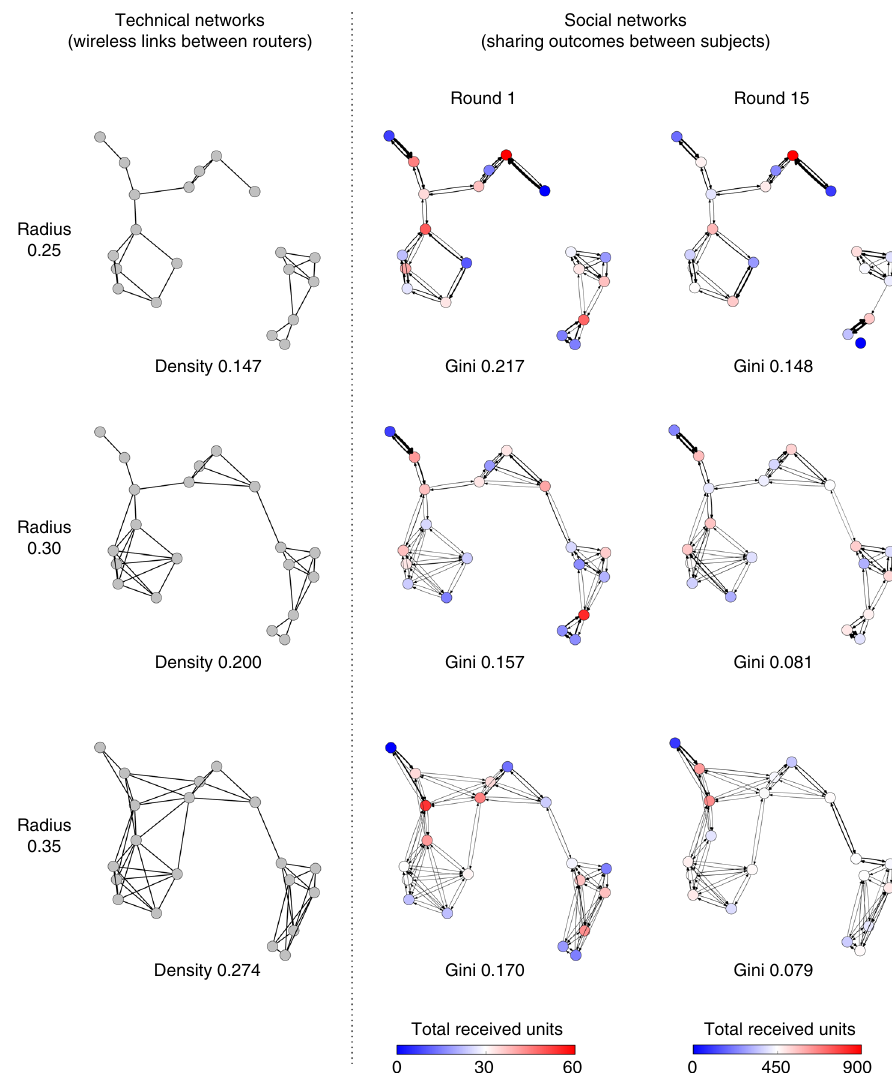
Fig. 2 Network snapshots and actual realized exchanges of a resource with different connection ranges. The network samples have the same geometric con fi guration (i.e., location of the nodes on the plane) but different connection ranges. In the social networks, node color indicates total received units (with redder nodes being richer; with bluer nodes being poorer). Arrow width indicates total given units from sender to receiver (with line width indicating more giving to the neighbor indicated with the arrowhead). In addition, the graphs exclude extra-thin arrows according to the threshold that the given units are less than 10% of total resources. Both properties are normalized with the number of rounds. As the session progressed, the players selected sharing partners to seek mutual exchange. As a result, the wealth gap